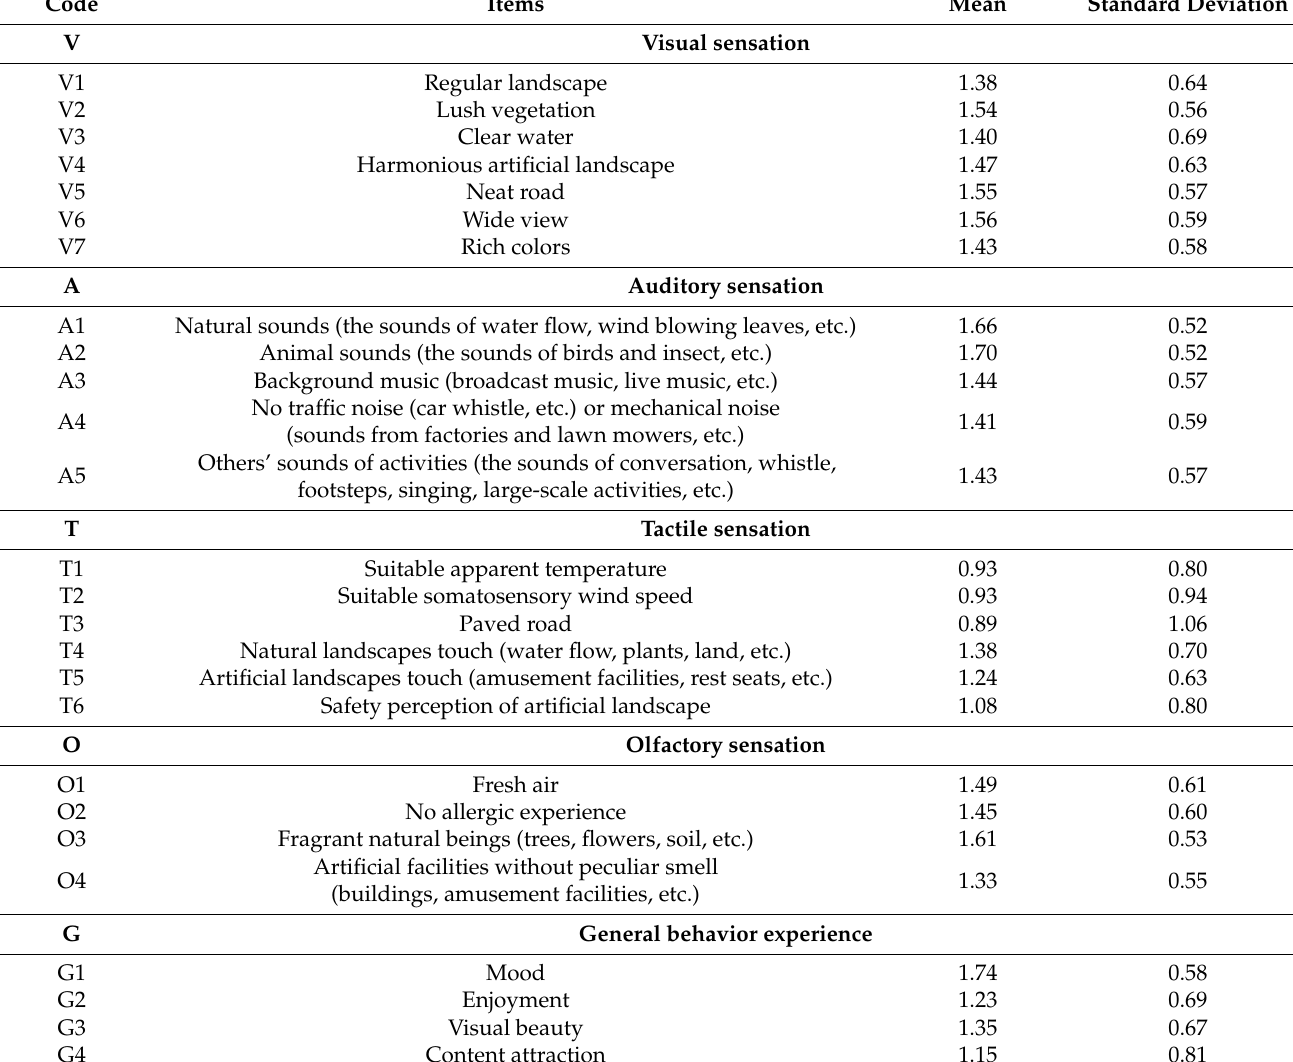
Table 3. Descriptive analysis of the perception of multi-sensory experiences in the urban forest park ( n =